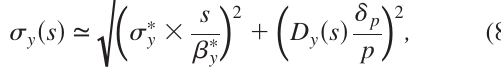
exit window is placed 150 m away from the interaction point, where the vertical dispersion is 11.1 cm. Assuming an energy spread of 1% for the noncolliding beams, (cid:1) is 3 mm 2 at the end of the post-collision line.